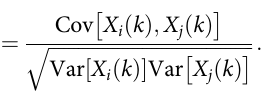
Fig. 3c: At each time instance k , a collective momentum, P N M ð k Þ ¼ X j ð k Þ , that corresponds to the instantaneous sum j ¼ 1 of all processes is calculated. The calculation of M ( k ) incurs little computational effort as it just counts the number of non-zero events at each time instance. Next, an identical SET pulse is applied potentially in parallel to all the PCM devices for which the assigned binary process has a value of 1. The duration or amplitude of the SET pulse is chosen to be a linear function of M ( k ). For example, let the duration of the pulse P δ t ð k Þ ¼ CM ð k Þ ¼ C N X j ð k Þ . For the sake of simplicity, let us j ¼ 1